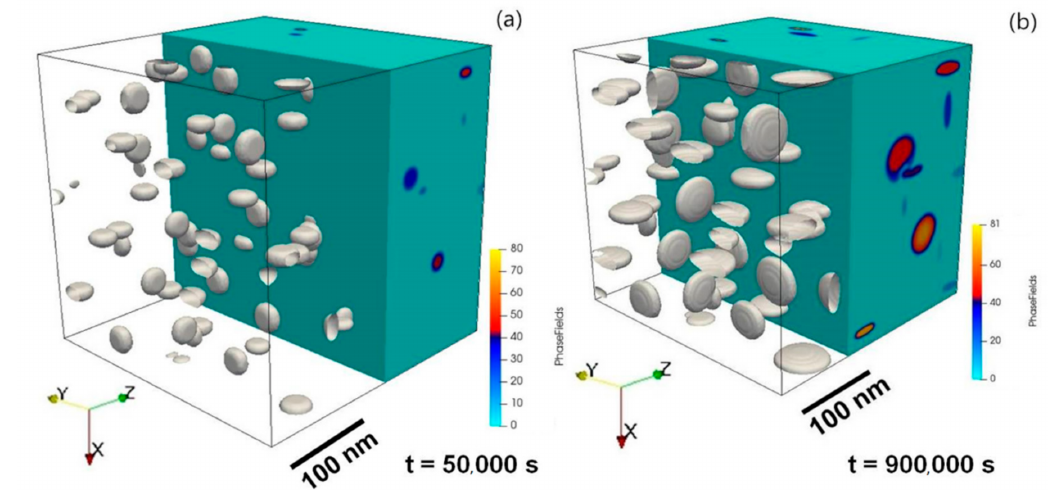
Figure 11. 3D large scale phase-field simulated microstructure evolution of θ (cid:48) precipitation process in Al-1.69 at.% Cu alloy annealed at 453 K: ( a ) Aging time step = 50,000 s; ( b ) aging time step = 900,000